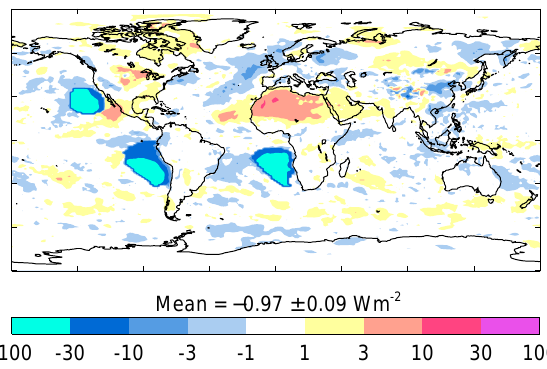
Fig. 10. RFP (Wm − 2 ) due to modified marine stratocumulus clouds from Jones et al. (2009) (Wm − 2